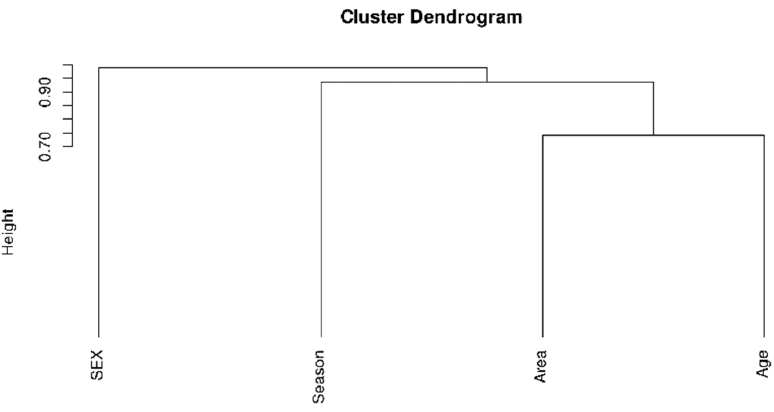
Figure 1. Dendrogram showing the relationship among variables affecting probable cases of Q fever.